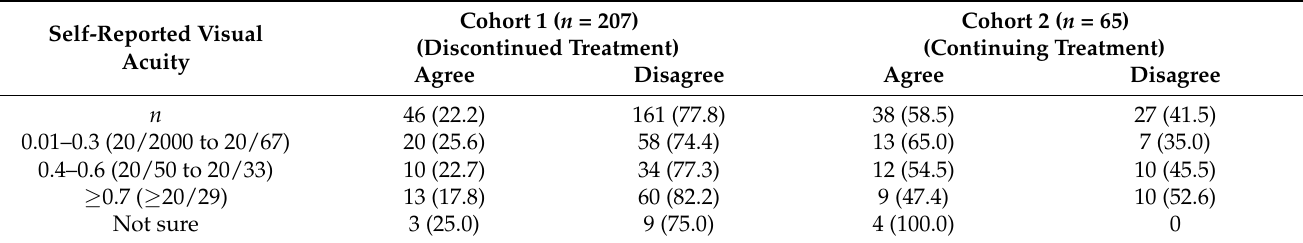
Table 4. Self-reported visual acuity of the affected eye and agreement with the response “treatment was ineffective”. Patients were asked about whether they agreed or disagreed with the response “Because the treatment was ineffective”. Values are n